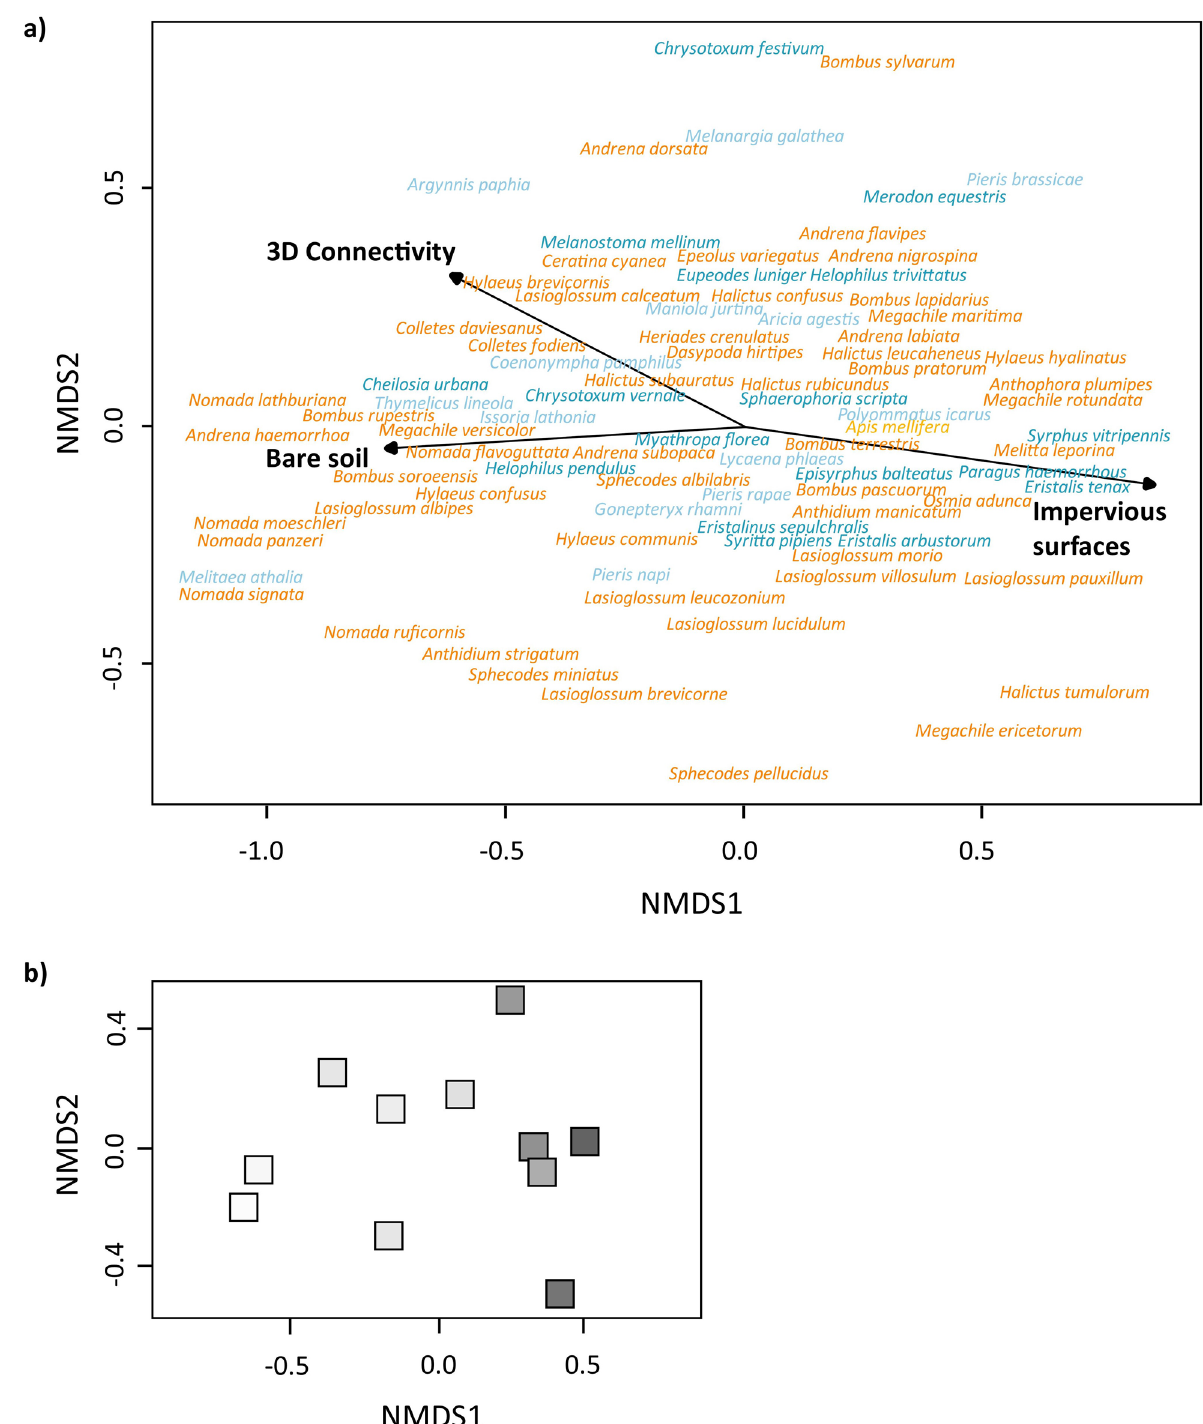
Figure 2. ( a ) Non-metric multidimensional scaling (NMDS) ordination of overall pollinator communities (stress value: 0.062). Impervious surfaces (500 m; P = 0.003), 3D Connectivity (P = 0.043) and the amount of bare soil (P = 0.034) are important factors that structure pollinator communities. Wild bee species are displayed in orange, hoverflies in dark blue, butterflies in light blue and honey bees in yellow. ( b ) The structuring of pollinator communities by impervious surfaces is also reflected in the positioning of the study sites in the NMDS-plot. The colour of the study sites indicates the degree of urbanisation (light grey: low proportion of impervious surfaces; dark grey: high proportion of impervious